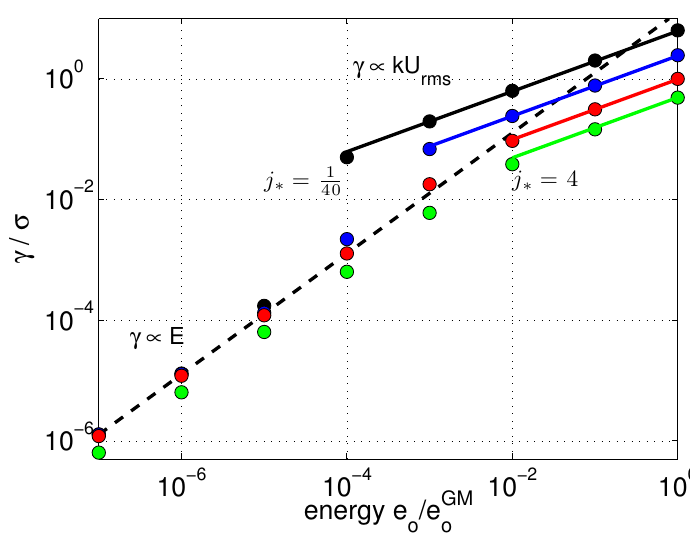
Figure 10. Bandwidth estimates versus spectral level, normalized by frequency σ . The dashed black line is the small amplitude limit of γ p (42). Colors differentiate estimates using different values of the GM76 bandwidth parameter m ∗ = [1/40 1/6 1 4] π /1300 m as [black blue red green]. The background spectra differ in total kinetic energy and Doppler shift but have the same asymptotic shear spectral density at high vertical wavenumber. The dots indicate numerical estimates using (42). The green dots lie below the others as the GM value of m ∗ = 4 π /1300 m challenges the assumption of a constant shear spectral density. The scaling regime of γ ∝ kU rms is indicated by the solid lines connecting the numerical estimates. The ray tracing results reported here use a background with j ∗ = 1/40. The transition in bandwidth scaling for the DIA equations happens at far smaller amplitudes ( e o / e GM o ∼ = 1 × 10 − 4 )